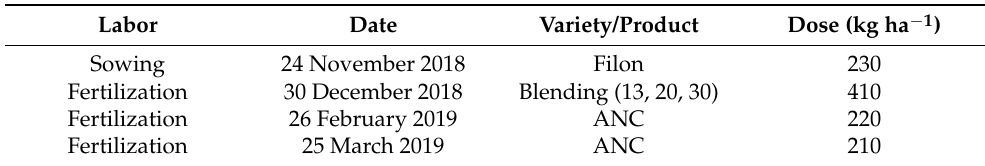
Table 1. Sowing and fertilization carried out on the study plots, specifying date, the product/wheat variety, and dose applied.